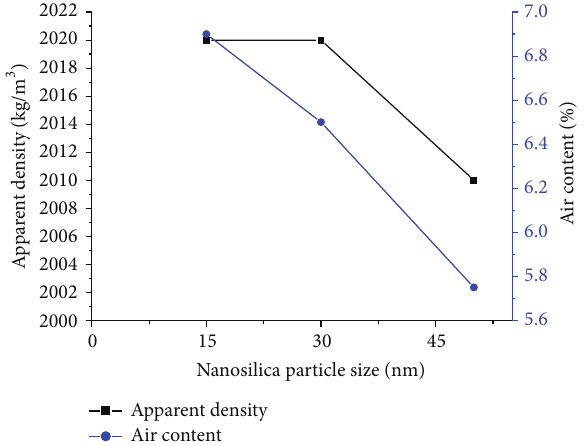
Figure 7: Influence of NS particle size on air content and apparent density of the mortar.